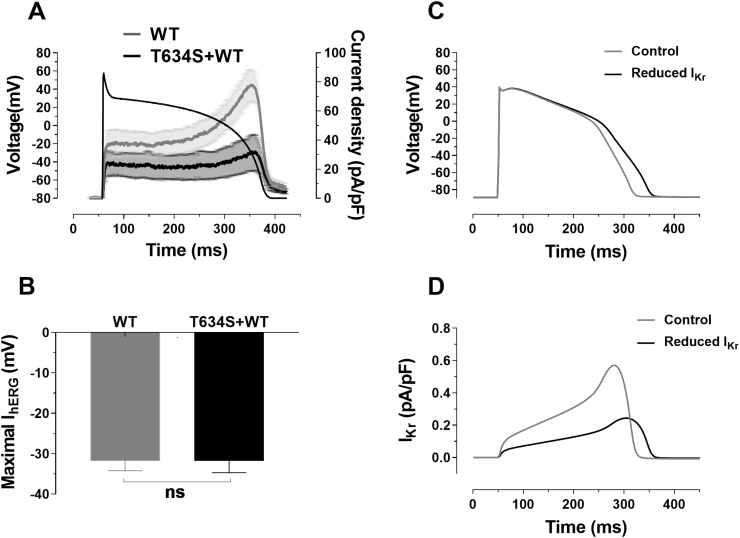
IhERGduring ventricular action potentials: AP clamp and AP simulation.A) Means ± SEM IhERG for WT (n = 5) and WT+T634S conditions (n = 5). Corresponding action potential (AP) command is superimposed on the plotted normalized currents. Co-expression of WT and T634S suppressed current compared to WT hERG alone.B) Bar chart comparing the voltage (for WT and WT+T634S) where peak IhERG occurred during AP repolarization, WT (n = 5) and WT+T634S (n = 5; P > 0.05 versus WT, unpaired t-test).C) Epicardial action potentials from the O’Hara-Virag-Varro-Rudy model generated under control conditions at 1 Hz stimulation frequency and with reduced IKr (gKr reduced by 57.1%).D) Corresponding IKr records during the control and reduced IKr APs shown in C.